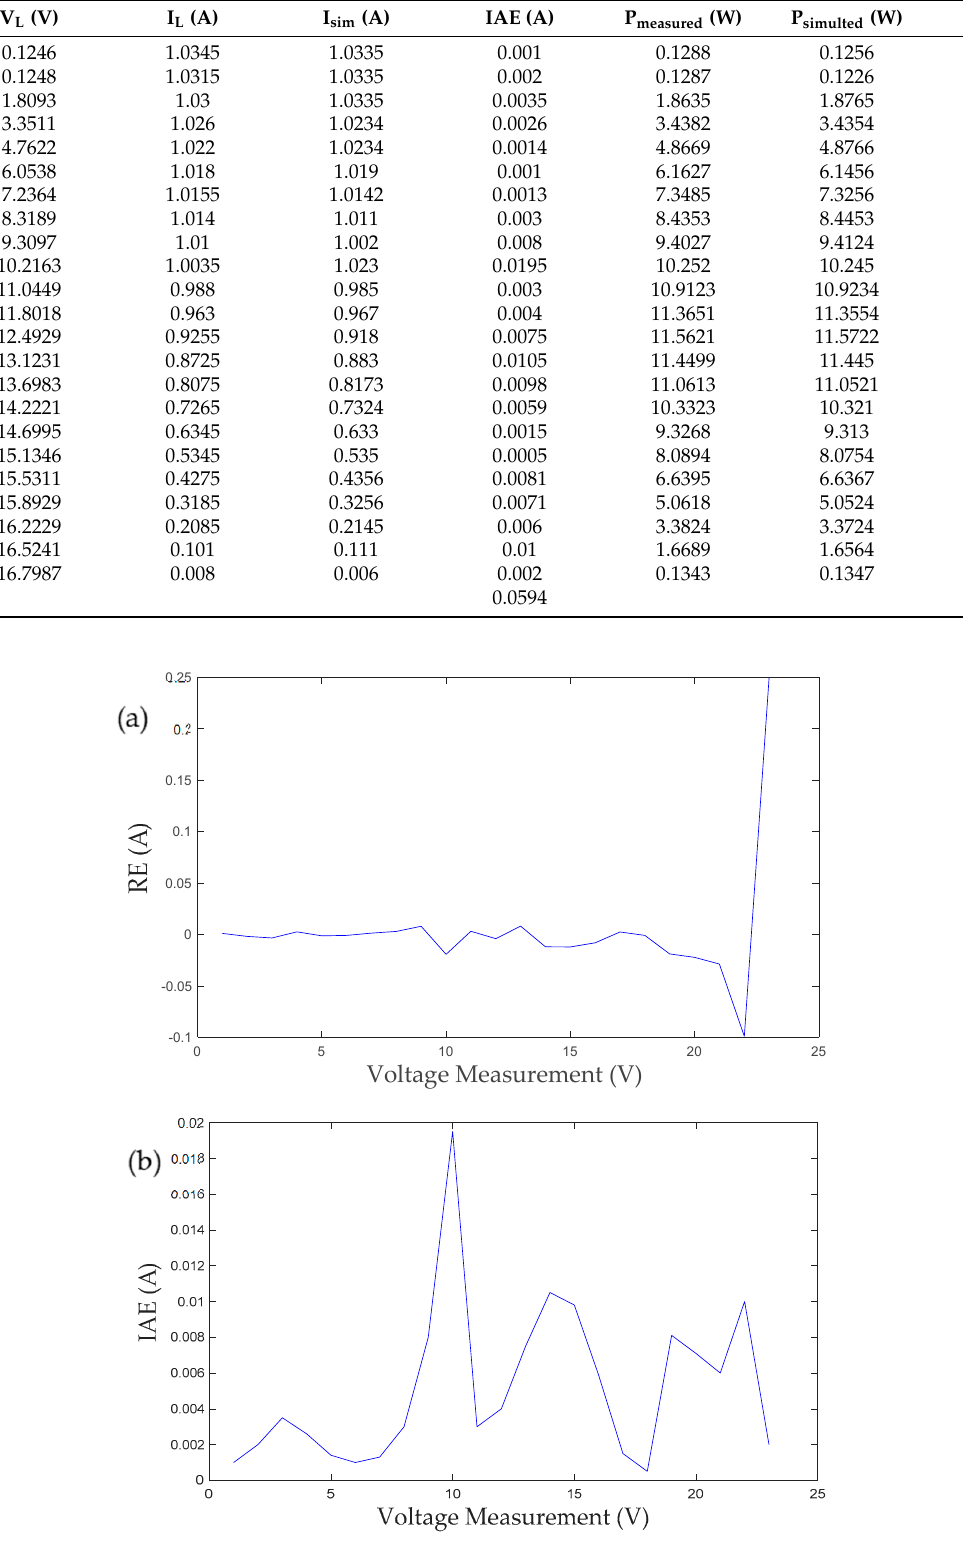
Figure 4. ( a ) Internal absolute error and ( b ) relative error curve between measured and estimated current for Photowatt-PWP201 PV Module. Table 3. The calculated current and absolute error results of TSA (Tunicate swarm algorithm) for solar PV (Photovoltaic) module.